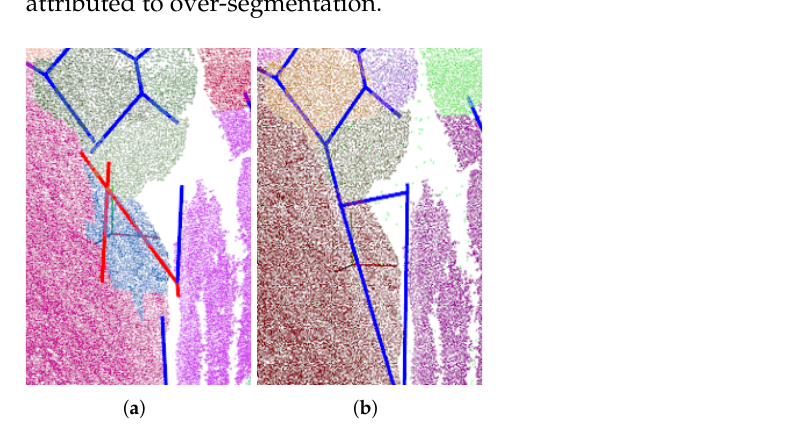
Figure 7. Adaptive adjustment. ( a ) An example of the collision area. ( b ) The reconstruction result without